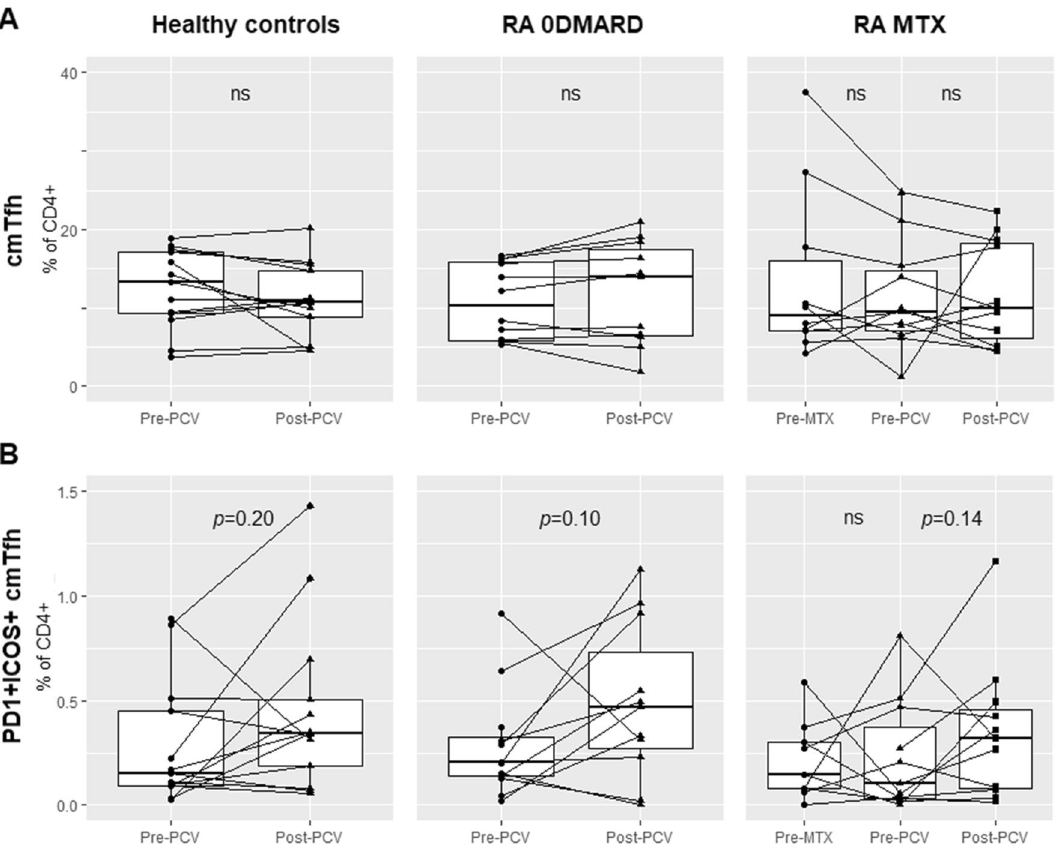
Figure 3. Circulating memory T follicular helper cells (cmTfh) in % of CD4 + ( A ), and activated, PD-1 + ICOS + cmTfh ( B ), in HC and RA 0DMARD groups: before and after PCV, and in MTX group: before start of MTX, before and after